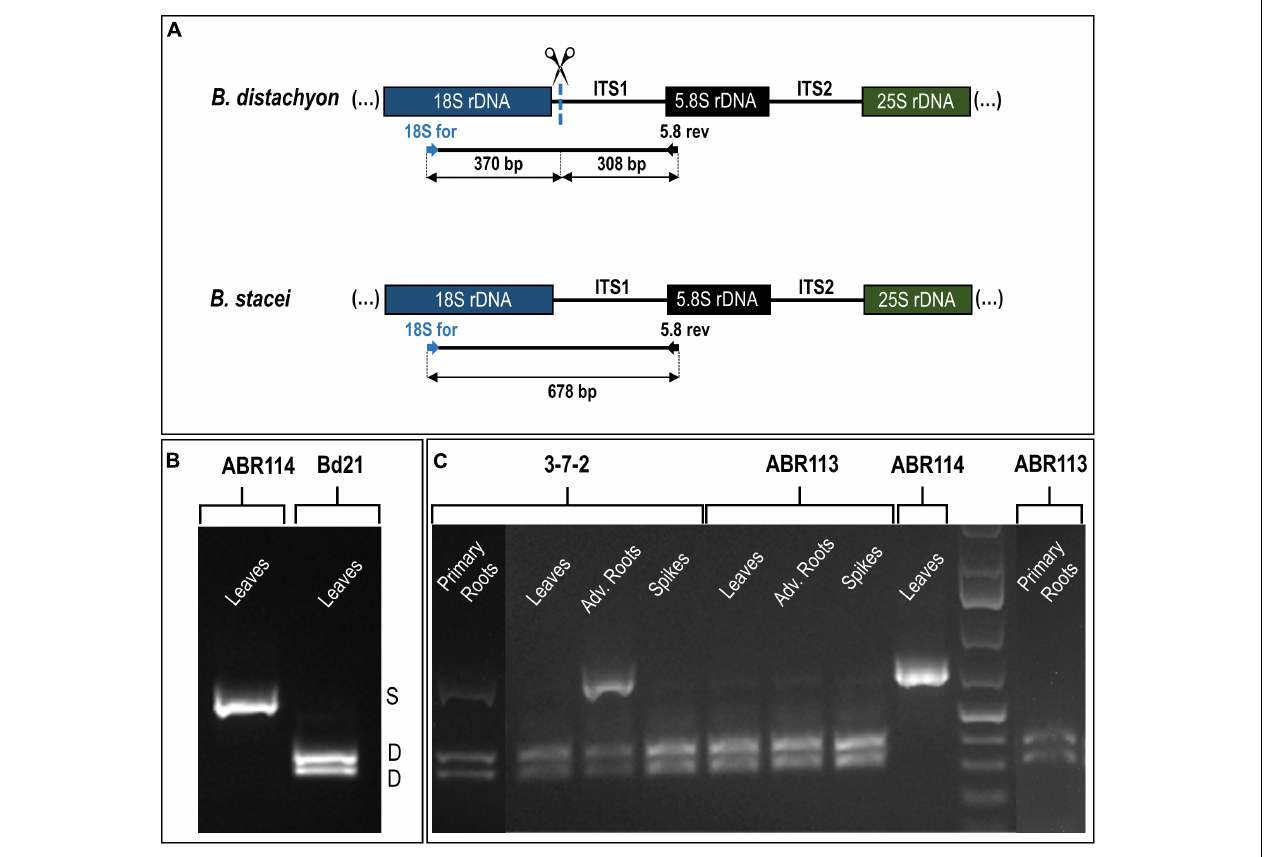
FIGURE 3 | The 35S rDNA expression analysis in the different tissues of B. hybridum (genotypes 3-7-2 and ABR113) and B. stacei (genotype ABR114; control) and B. distachyon (genotype Bd21; control) using the RT-PCR CAPS method. (A) The Mlu I restriction profile of the B. distachyon -like and B. stacei -like ITS1 PCR products. The expected sizes of the bands after Mlu I digestion are presented. (B) The Mlu I restriction profiles of ITS1 amplification products that were obtained from the leaves cDNAs of B. distachyon and B. stacei . (C) The Mlu I restriction profiles of ITS1 amplification products that were obtained from the primary roots,